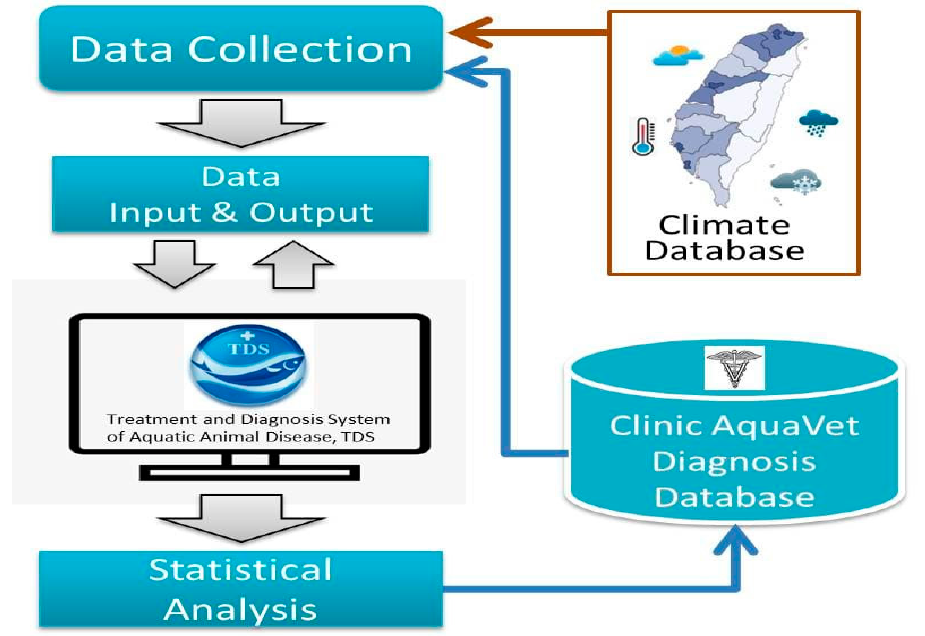
Figure 1. The structural diagram of the treatment and diagnosis system (TDS) shows how the system analyzes data and provides information for clinical diagnosis. TDS integrates climate data from the weather station (climate database) and clinical data from the veterinarian (clinical AquaVet) to do statistical analysis. The result of statistical analysis can predict which factors are risk factors to specific diseases in aquaculture, which can provide information to the veterinarians in the front line. TDS also provides registered member inquiry service (reverse arrow).